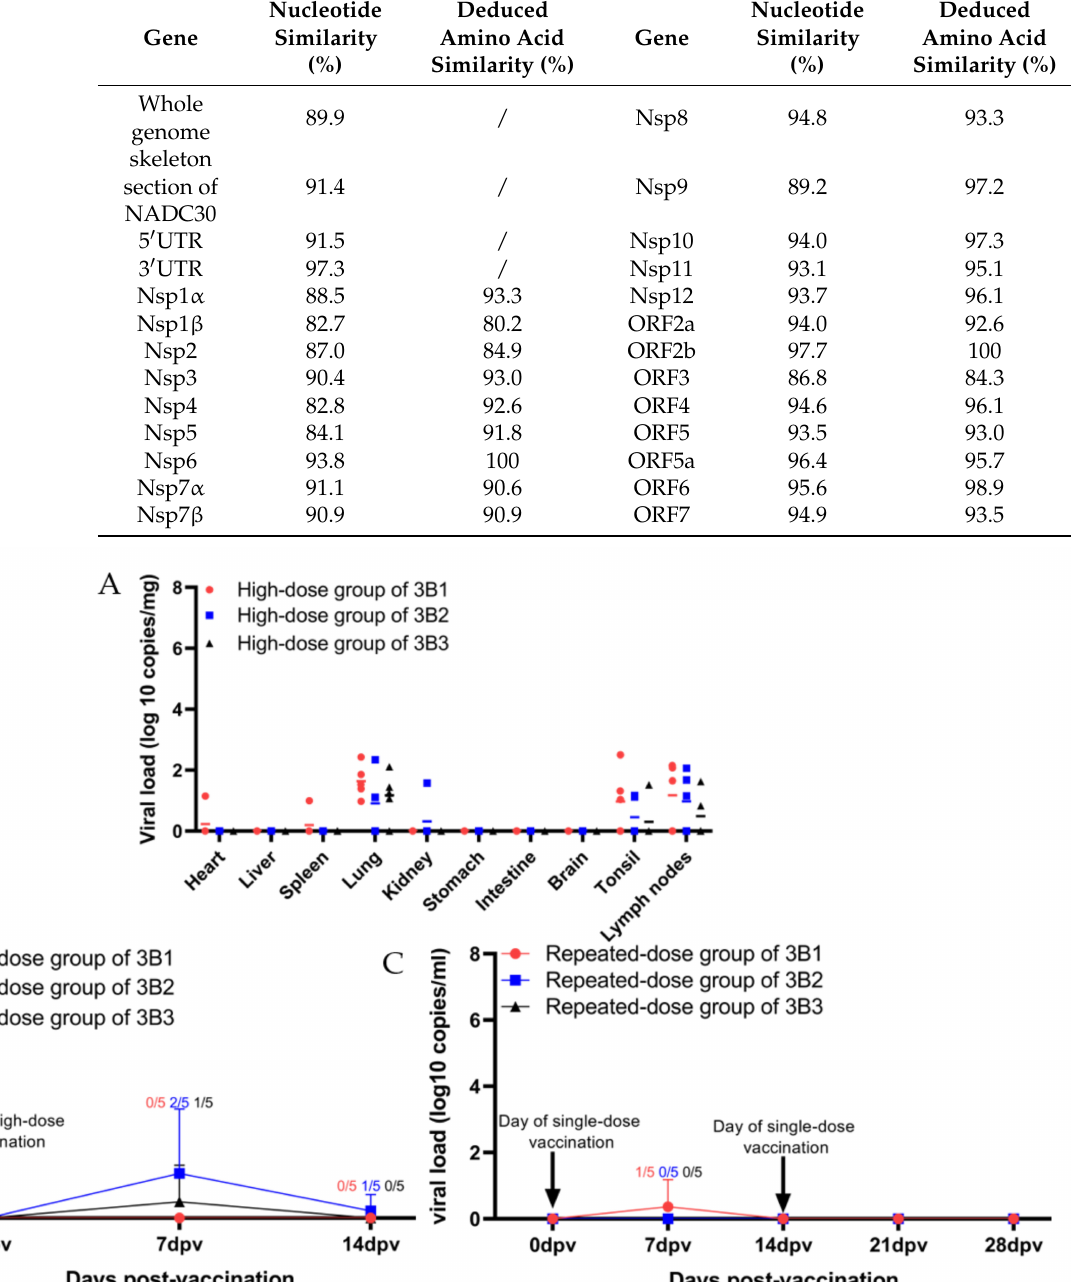
Table 3. The nucleotide and deduced amino acid similarity between SD and HLJWK108-1711.